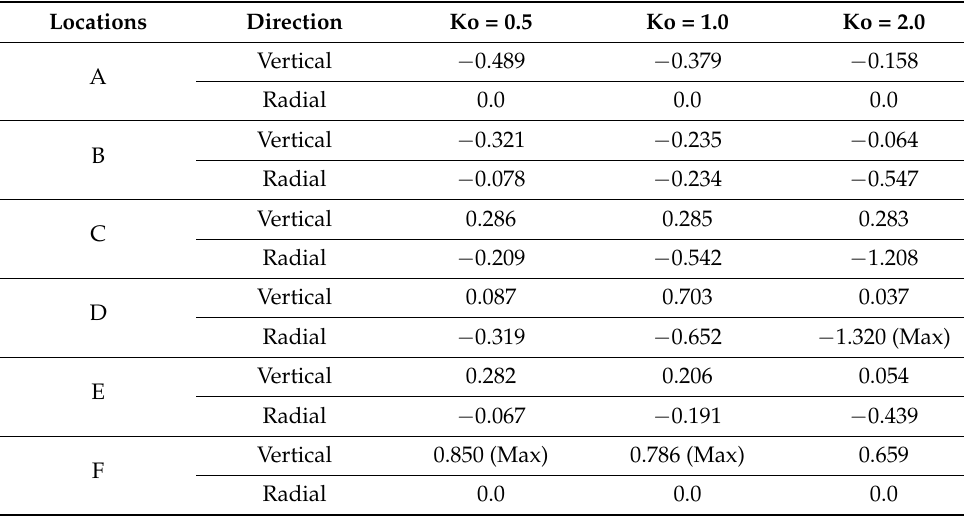
Table 5. Displacements at key locations obtained through 3D analysis (unit: